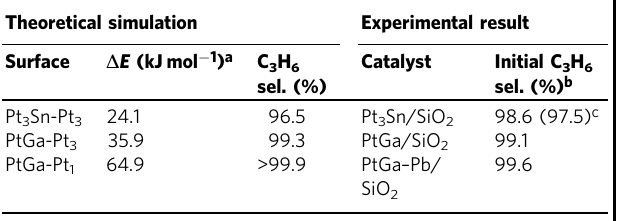
Table 1 Theoretical and experimental C 3 H 6 selectivity in PDH at 600 °C. Theoretical simulation Experimental